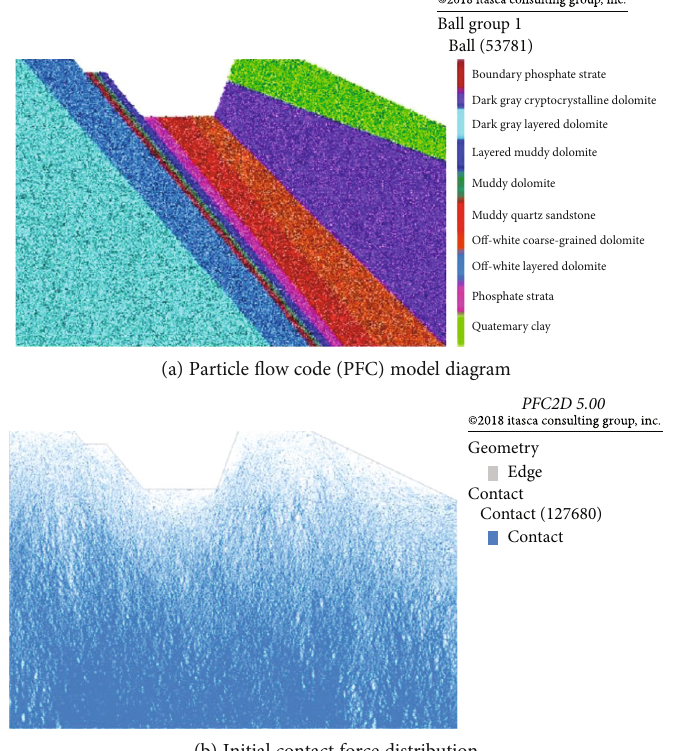
Figure 5: Particle fl ow code (PFC) model diagram and initial contact force